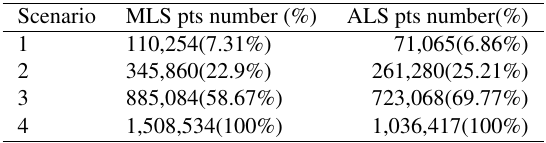
Table 3: Scenarios of down-sampled points For the Source point cloud 7 . 31% , 22 . 9% and 58 . 67% of the original points are kept and for the Target point cloud 6 . 86% , 25 . 21% and 69 . 77% of the points are kept for comparison. Based on those scenarios, the two algorithms are compared.